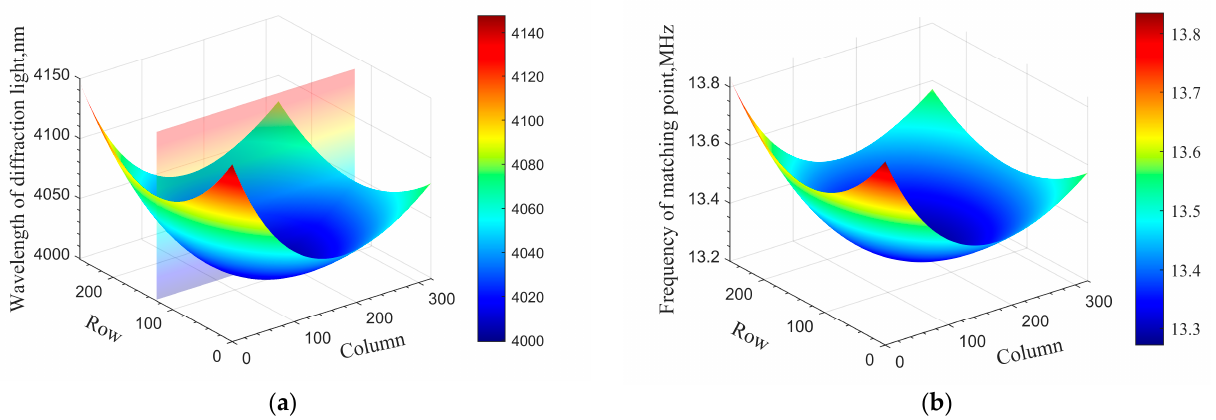
Figure 3. Mid-infrared AOTF image plane drift. ( a ) Central wavelength drift and ( b ) central fre- quency drift.